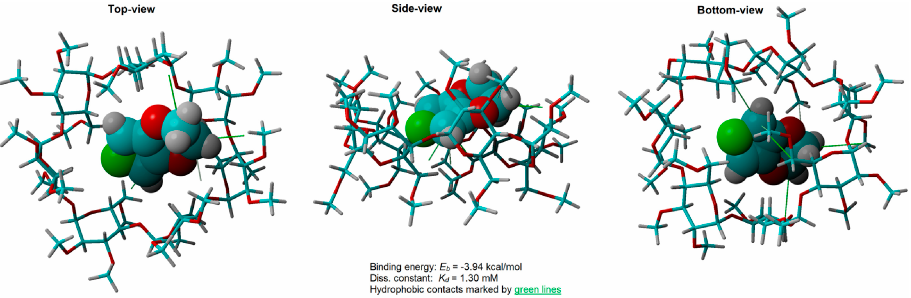
Figure 1. Molecular docking model of the host-guest EDOT ∙ TMe- β CD complex formation; hydrophobic contacts illustrated as solid green lines.